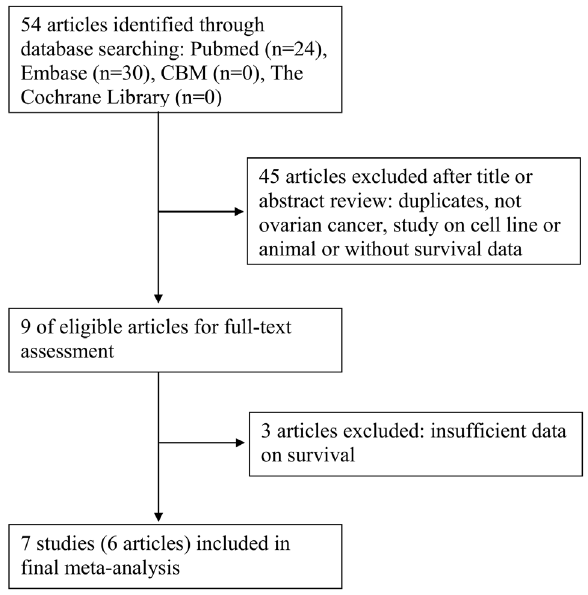
Figure 1. Flow chart of searching the relevant studies used in this